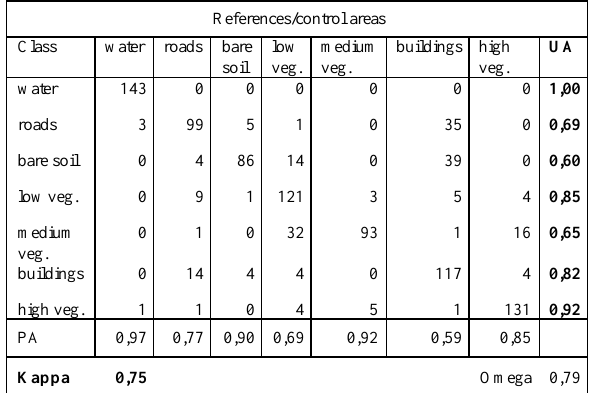
Table 1. Maximum Likelihood classification results for “W” area